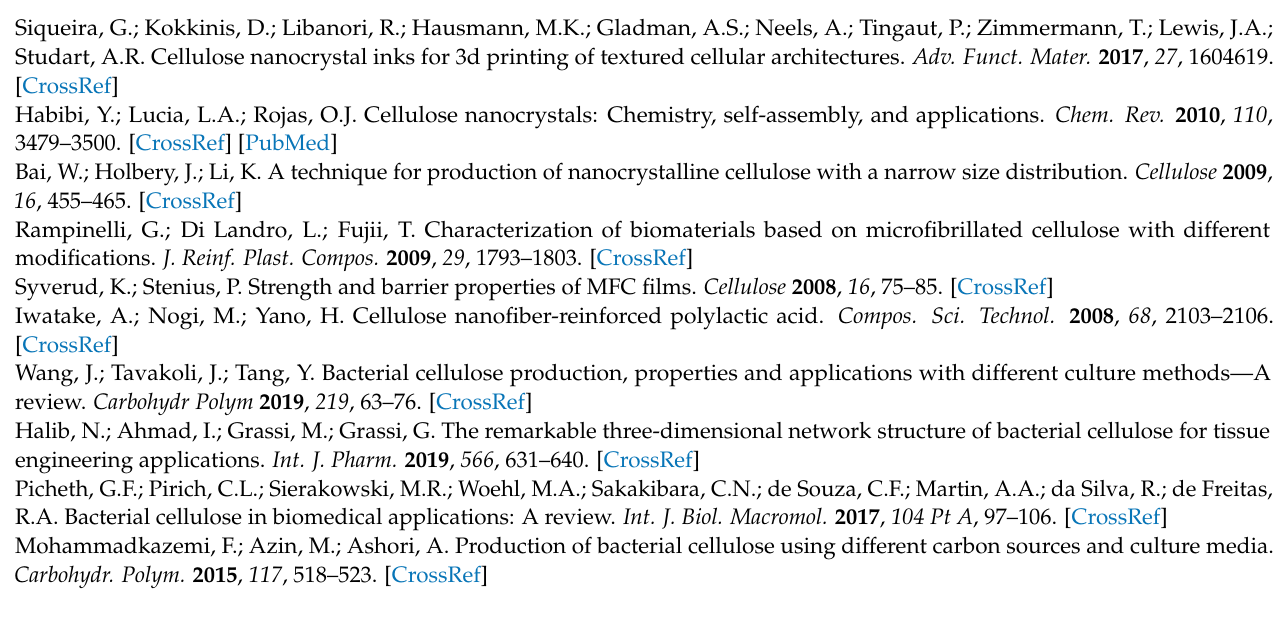
Figure S1. CNF emulsion pictures of (a) the mixture of oil-water before homogenization, (b) CNFX%-DDAB0.1% and (c) CNFX%-DDAB0.5%. Figure S2. The appearance of CNF emulsion of (a) CNFX%-DDAB0.1% and (b) CNFX%-DDAB0.5%. Figure S3. The actual photo and its sectional view of liquid cell that used to load CNF emulsion. Figure S4. The dielectric raw data of 0.1 wt.% DDAB emulsion of (a,b) CNF1%, (c,d) CNF1.5%, (e,f) CNF2% and (g,h) CNF2.5% at all time intervals with the real and imaginary parts of permittivity and loss angle on dependence of dielectric frequency. Figure S5. The dielectric raw data of 0.1 wt.% DDAB emulsion of (a,b) GO1% and (c,d) GO1.5% at all time intervals with the real and imaginary parts of permittivity and loss angle on dependence of dielectric frequency so as to compare the common properties of CNF emulsion. Figure S6. The pictures of (a) before and (b) after dielectric tests of CNF emulsion relating to carbonization. Figure S7. The original data of startup-flow for 2 typical CNF emulsions. 1–4 ramps of shear rate were plotted with stress and normal force but the first ramp did not behave well because previous large deformations do not largely change the structure. Figure S8. (a) Zeta-potential raw data for a sample with DDAB/CNF-ratio of 0. (b) Zeta-potential vs.